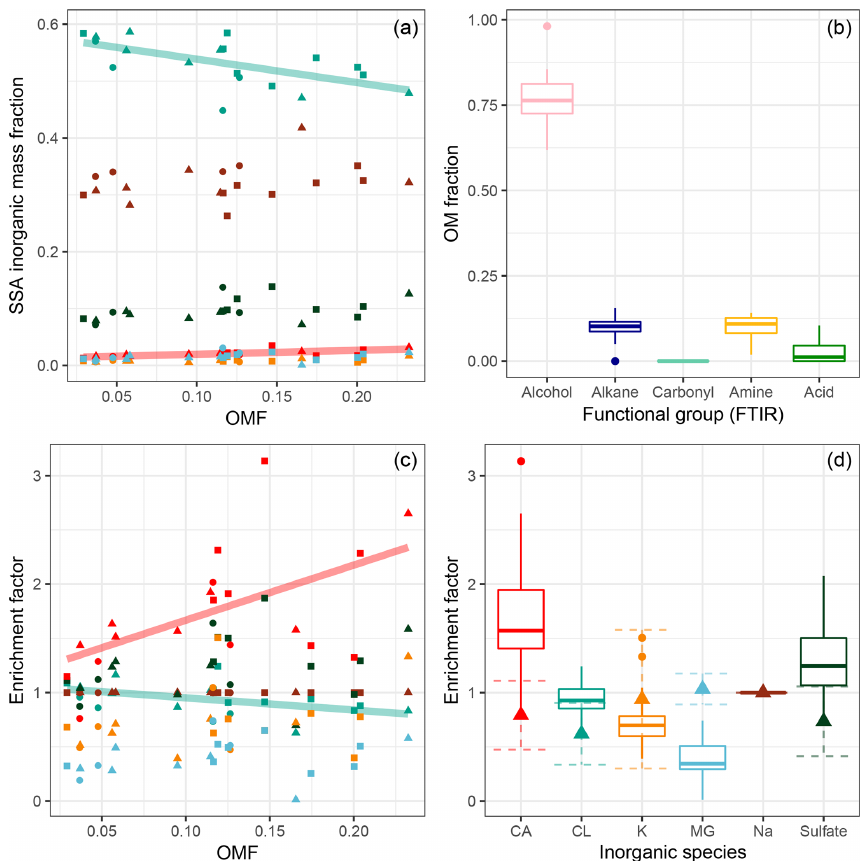
Figure 7. Inorganic mass fraction (a) and enrichment factor (c, d) versus organic mass fraction (c) measured from IBA and FTIR analysis of filter samples. Enrichment factors of inorganic species are with respect to laboratory-prepared seawater and presented with respect to Na + . Panels (a) and (c) show linear trends for species with statistically significant correlations (Cl fraction displayed R 2 of 0.34, p value < 0.01 and slope of − 0 . 9 ± 0 . 3, and Ca fraction displayed R 2 of 0.42, p value < 0.01 and slope of 7 ± 2). Shapes indicate water sample depth. Colours in (a) and (c) correspond to inorganic species indicated in (d) . Triangles in (d) represent the mean EFs from TEM-EDX measurements of SSA generated from laboratory seawater; dotted error bars show standard deviation in the mean. Contribution to organic mass from functional groups measured by FTIR shown in (b) . In panels (b) and (d) boxes extend from the 25th to the 75th percentile, with the line showing the median; circles show measurements outside of the 95% confidence interval in the